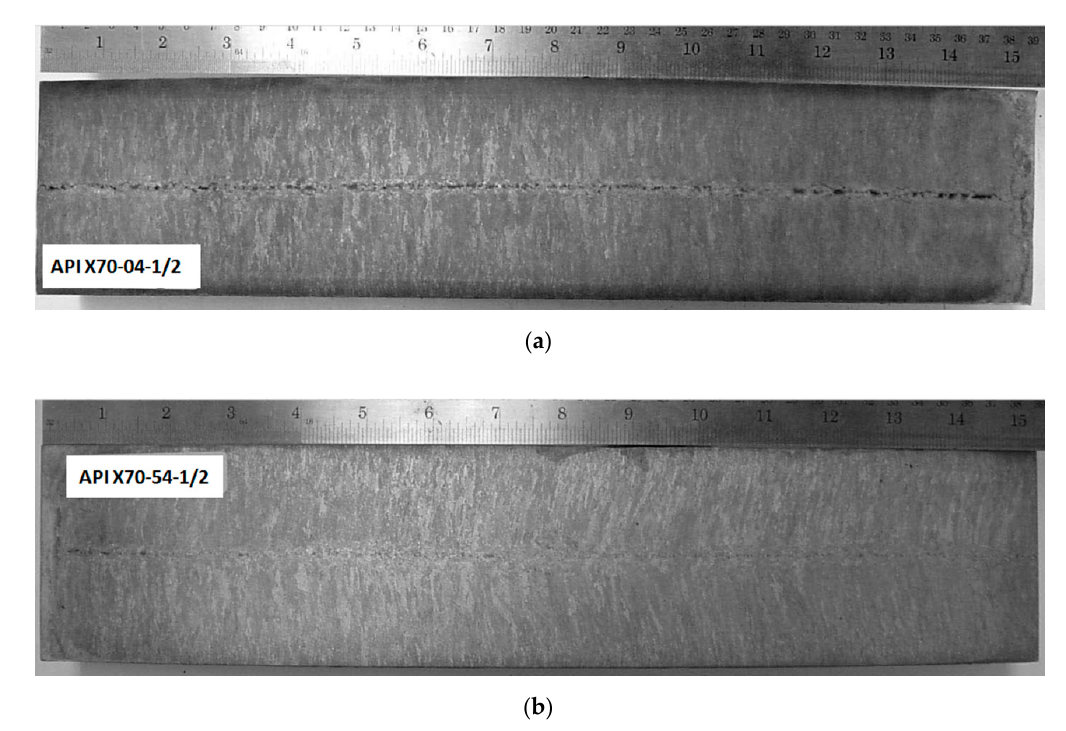
Figure 11. API X70 slab macro etch from: ( a ) strand 3; and ( b ) strand 4, with different set points of liquid core reductions.